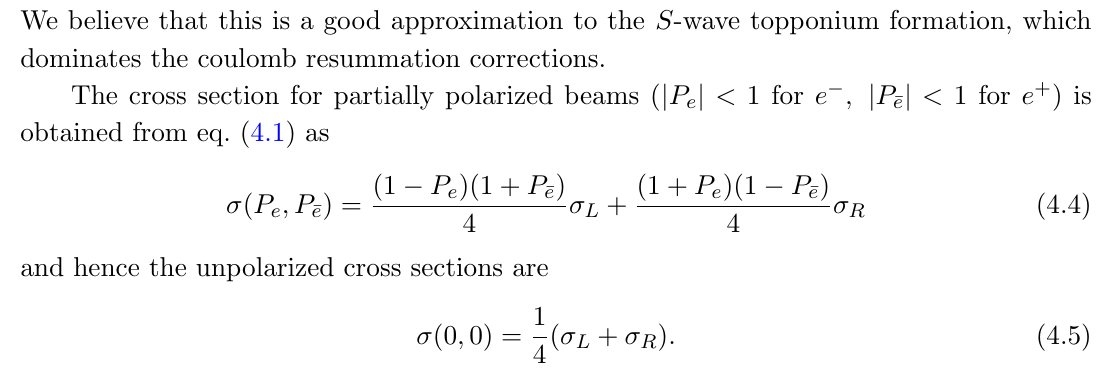
(cid:27) LO by (cid:27) NLO A